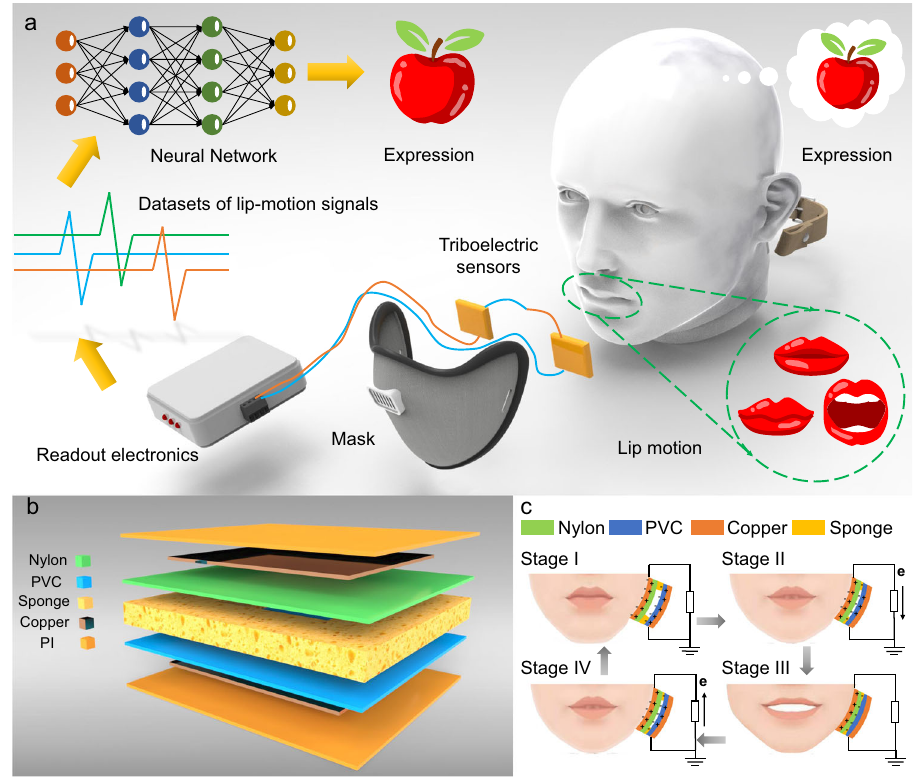
Fig. 1 The concept, structure and mechanism of the lip-language decoding system supported by triboelectric sensors. a Schematic illustration of the lip- language decoding system and its components, including triboelectric sensors, signal processing and deep learning classi fi ers. b Structure scheme for the fl exible triboelectric sensor. c Schematic diagram of four stages of charge transfer in one mouth open-close cycle. The mouth-opening process pushes the sensor, and the mouth-closing process releases the sensor, resulting in the fl ow of current in opposite pushing forces were varied by adjusting the spacing. The sensor is a square with length D and thickness T , as shown in the inset of Fig. 2b. Electrical signals generated by various materials (Paper/ Polyethylene terephthalate (PET)/ Poly tetra fl uoroethylene (PTFE)/ Polyimide (PI) / Polyvinyl chloride (PVC)/ Fluorinated ethylene propylene (FEP)) contact nylon were recorded using a 20 × 20 × 5 mm 3 sensor with a force of 5 N at a frequency of 2 Hz, as shown in Supplementary Fig. 2a. Both PVC and FEP show better output performance with nylon, and PVC is chosen for its better toughness. The open-circuit voltage and short-circuit current curves are shown in Supplementary Fig. 2b, c.